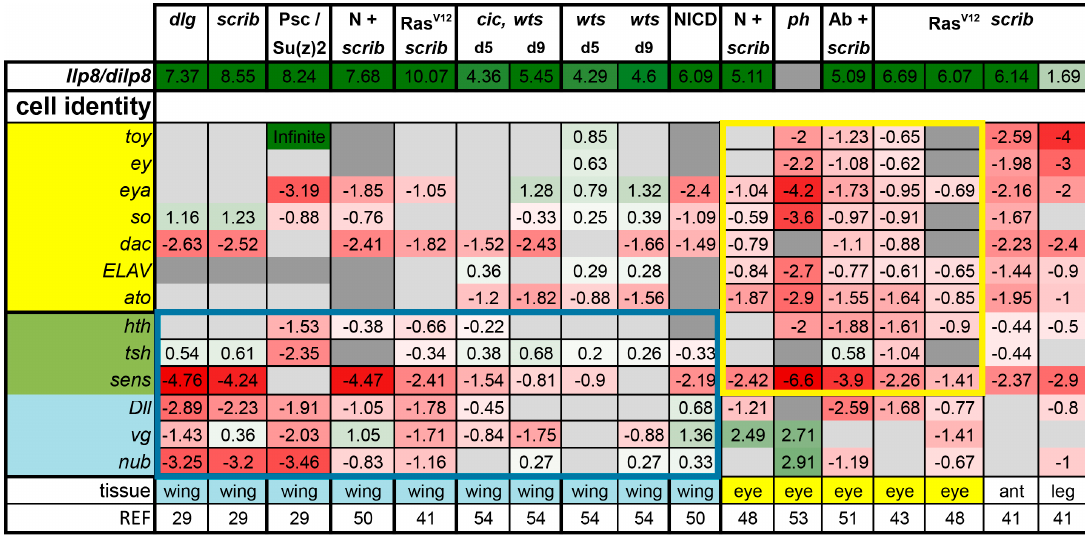
Figure 1. Expression levels of dilp8 and cell fate determinants in various tumor models. Samples were grouped according to their tissue of origin. Genes that act in the retinal determination network and their downstream effectors are highlighted in yellow, whereas genes required for cell fate determination in the wing are highlighted in blue. Three genes with developmental roles in both tissues are highlighted in green. Gene expression is displayed as fold change in log2 (log2FC) compared with controls. Color coding corresponds to a heatmap with a scale from -5 (dark red, downregulation) to 5 (dark green, upregulation). The midpoint, 0, is white. Light grey cells represent non-significant changes with p > 0.05. Cells are shown in dark grey if the gene was not found in the datasets owing to different cut-offs used by different groups. Abbreviations: Insulin like peptide 8, Ilp8; twin of eyeless, toy; eyeless, ey; eyes absent, eya; sine oculis, so; dachshund, dac; Embryonic Lethal Abnormal Vision, ELAV; atonal, ato; homothorax, hth ; teashirt, tsh; senseless, sens; Distalless, Dll; vestigial, vg; nubbin, nub ).